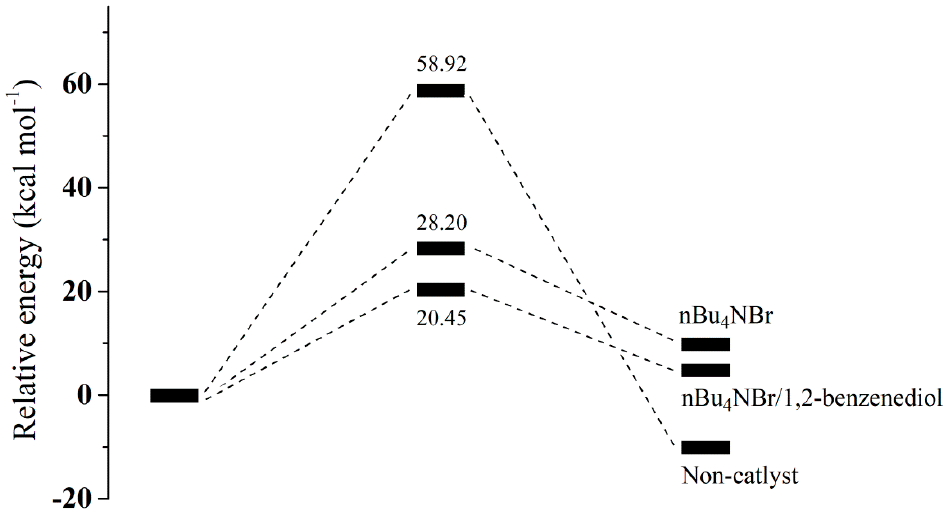
Figure 1. Comparison of the relative energy of the rate-determining step.